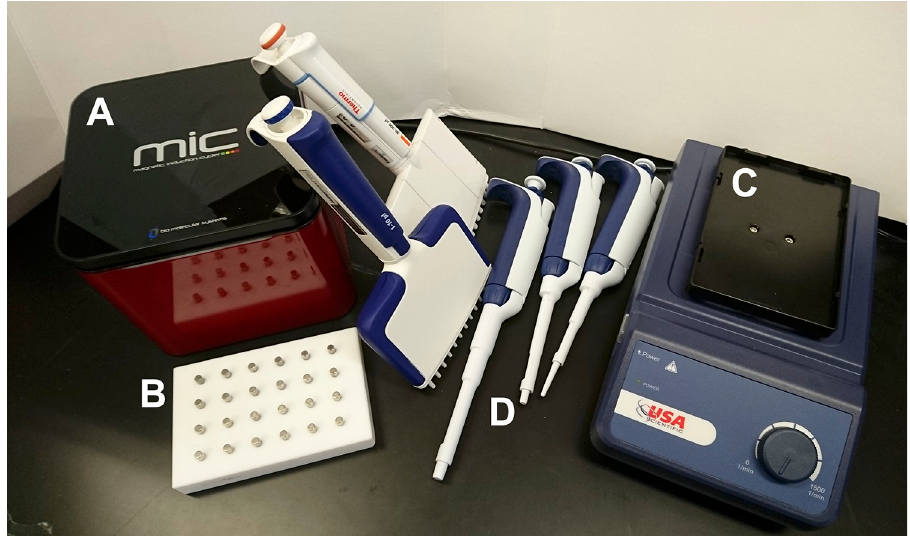
Fig 1. Instruments required for mobile qPCR. A) MIC 48-well qPCR instrument, B) magnetic block, C) plate shaker, D) pipettes.